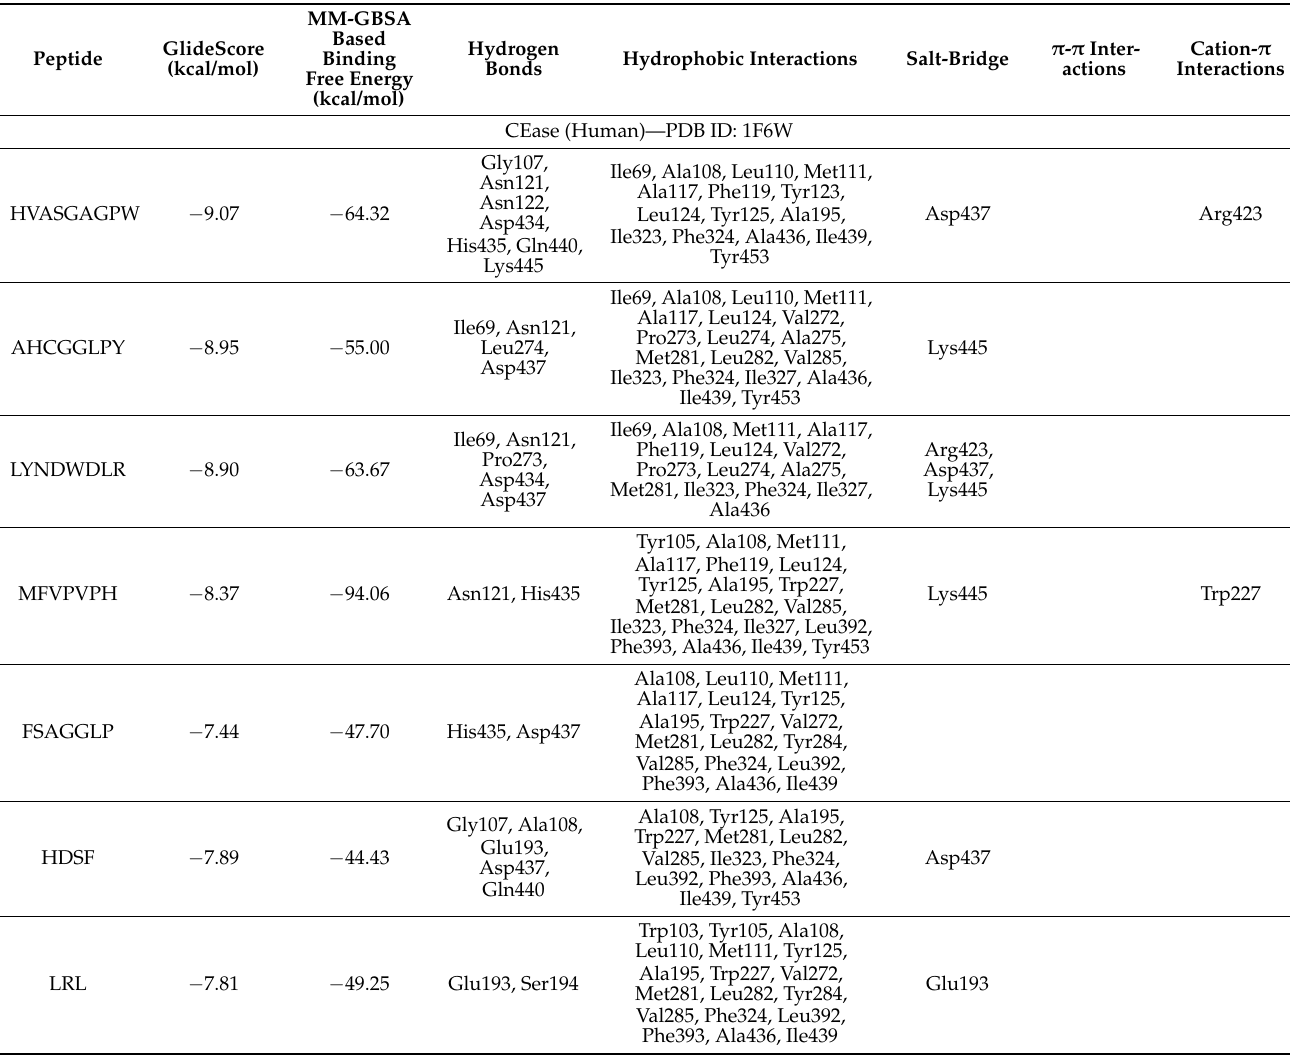
Table 4. Docking score (GlideScore), MM-GBSA binding free energy, and interacting residues of human and bovine CEase with the identified